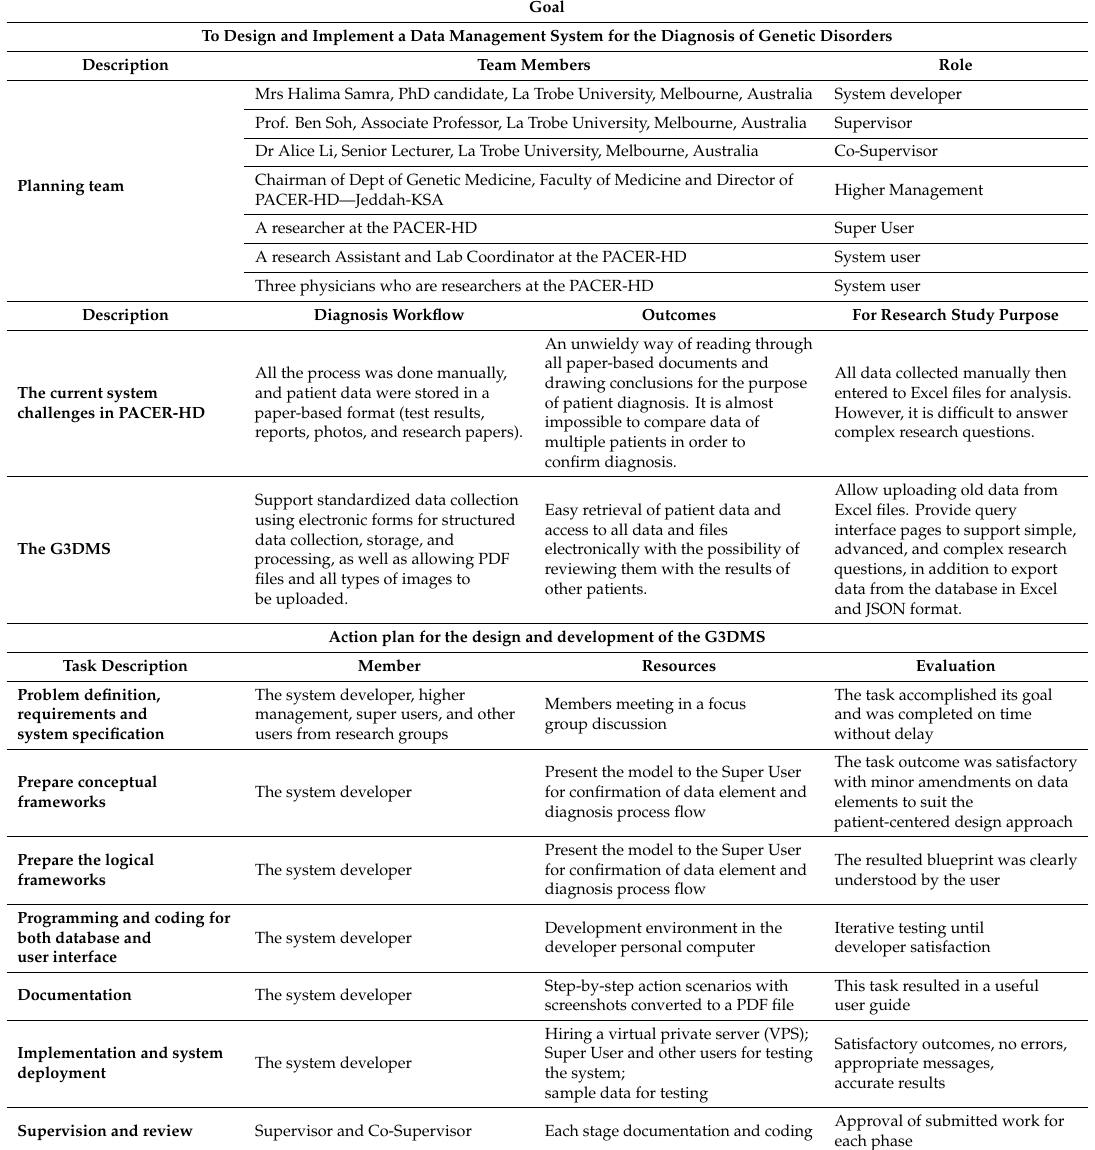
Table 6. The action plan